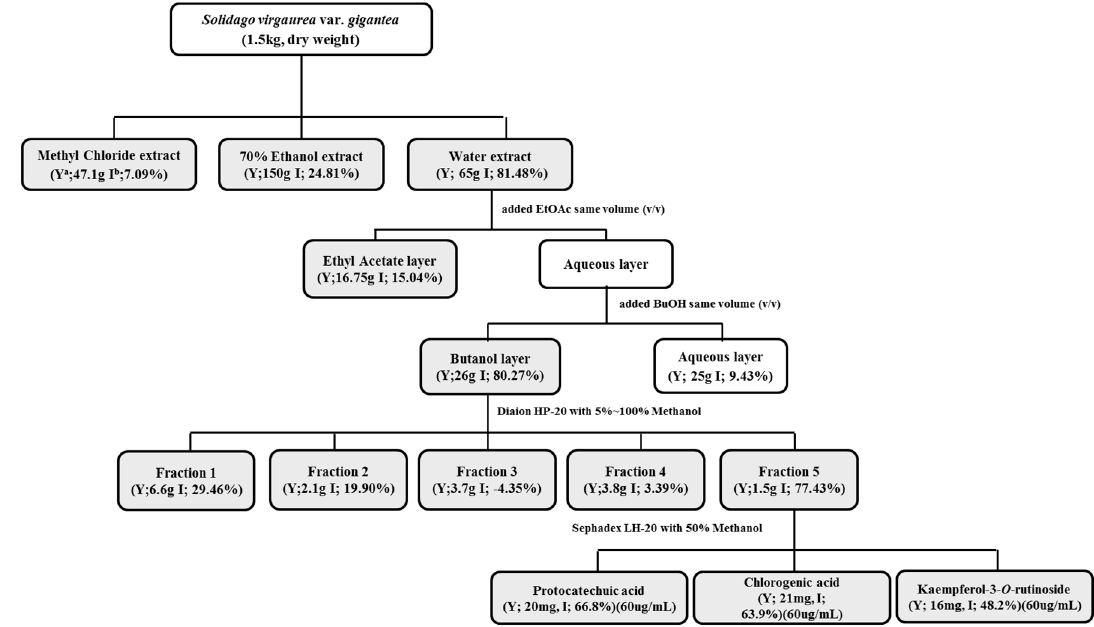
Figure 7. Extraction and fractionation of SV. a Yield; b Inhibition % (concentrations of protocatechuic acid, chlorogenic acid, kaempferol-3- O -rutinoside are 50 μ g/mL; concentrations of others are 10 μ g/mL).